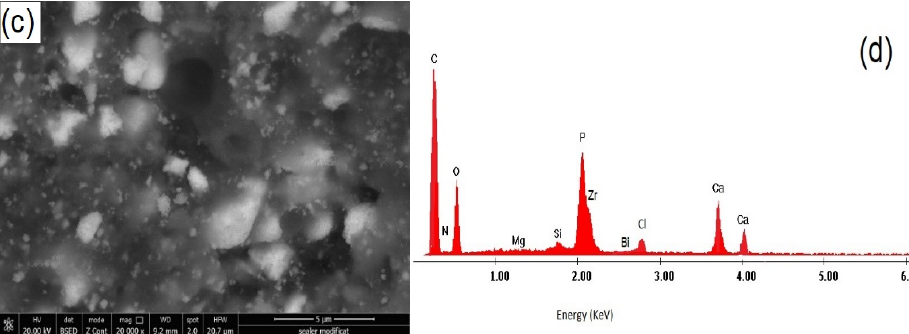
Figure 5. Ultrastructure details of commercial ( a ) and modified root canal sealer ( c ) along with the corresponding EDX spectrum ( b , d ).